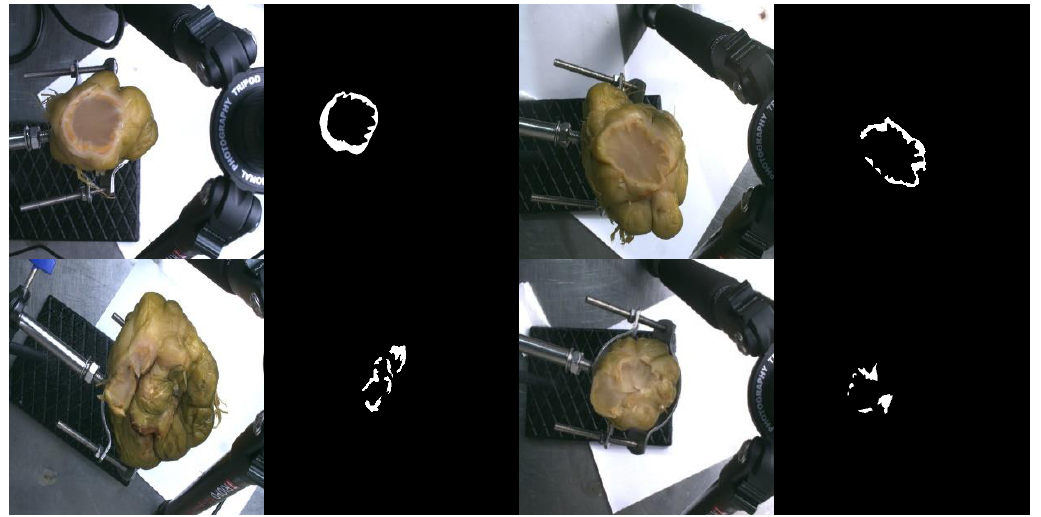
Figure 3. Some examples of the dataset. The two figures are a pair of data, with the image on the left and label on the